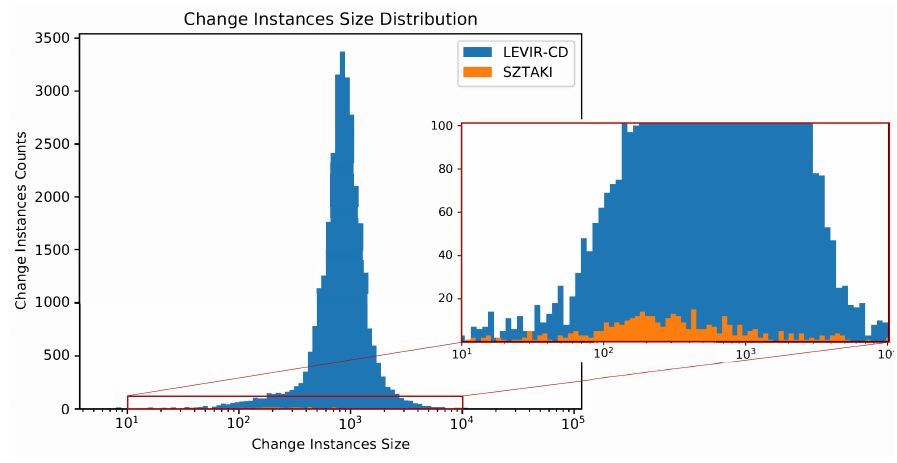
Figure 5. Distribution of change instance sizes (pixels) of LEVIR-CD and